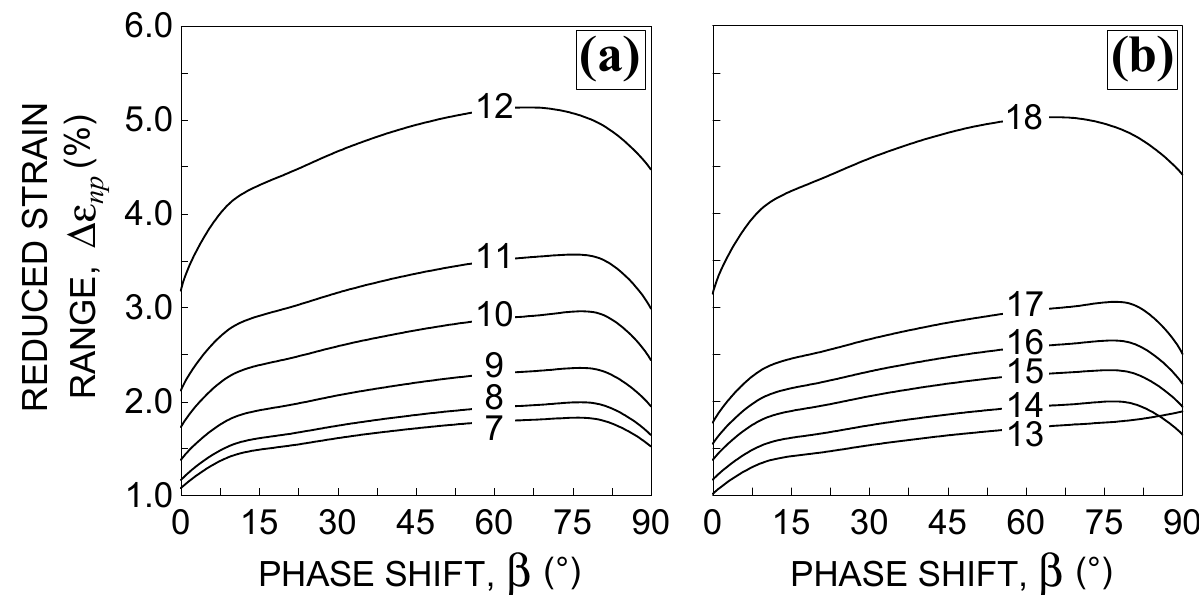
Figure 4. Influence of the phase shift β ( 0 ◦ ≤ β ≤ 90 ◦ ) on the reduced strain range ∆ ε np [3–5] for the loading conditions: ( a ) Nos. 7–12 and ( b ) Nos. 13–18, in Table 2.